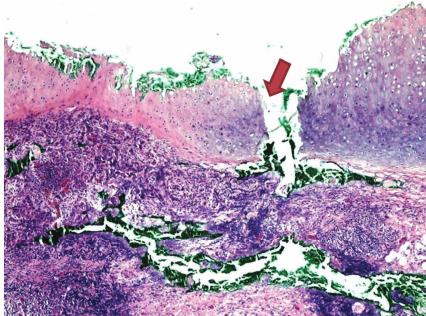
Figure 3: 40x magnification of a permanent section taken through the perforated cartilage (arrow). The anterior skin above the car- tilage is absent (status after curettage) and the posterior perichon- drium and dermis are seen inferior to the cartilage.